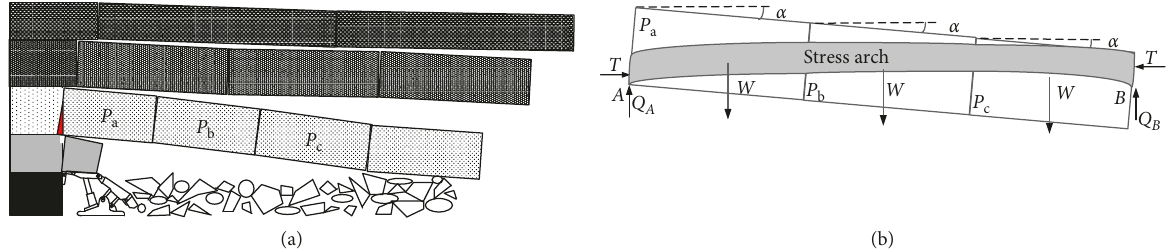
Figure 4: Rotative pressure-arch structure of key blocks of the periodic fractured roof. (a) Sketch map of the structure of key blocks. (b) Mechanical model.